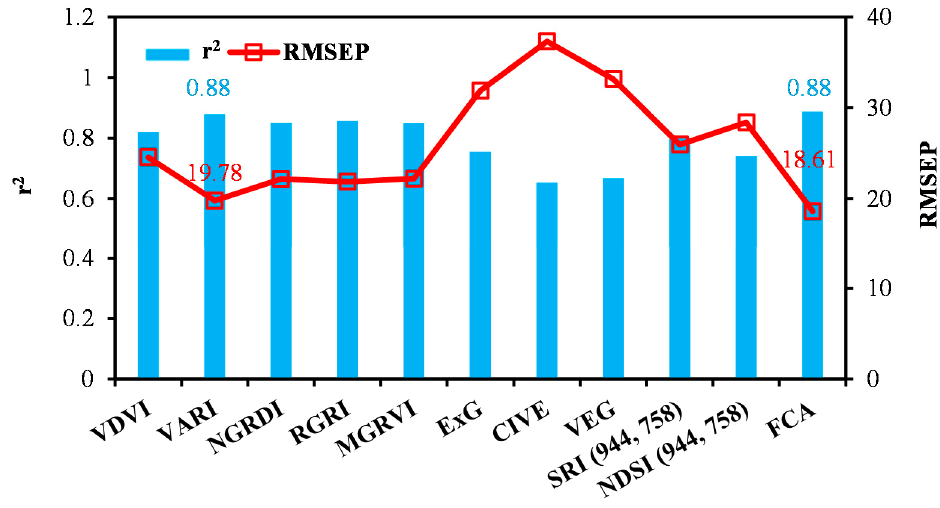
Figure 8. Estimation of flower number developed by random forest (RF) model using individual UAV variables including vegetation indices (VIs) and flower coverage area (FCA). The coefficient of determination (r 2 ) and the prediction of root mean square error (RMSEP) were presented to estimate the model performance.